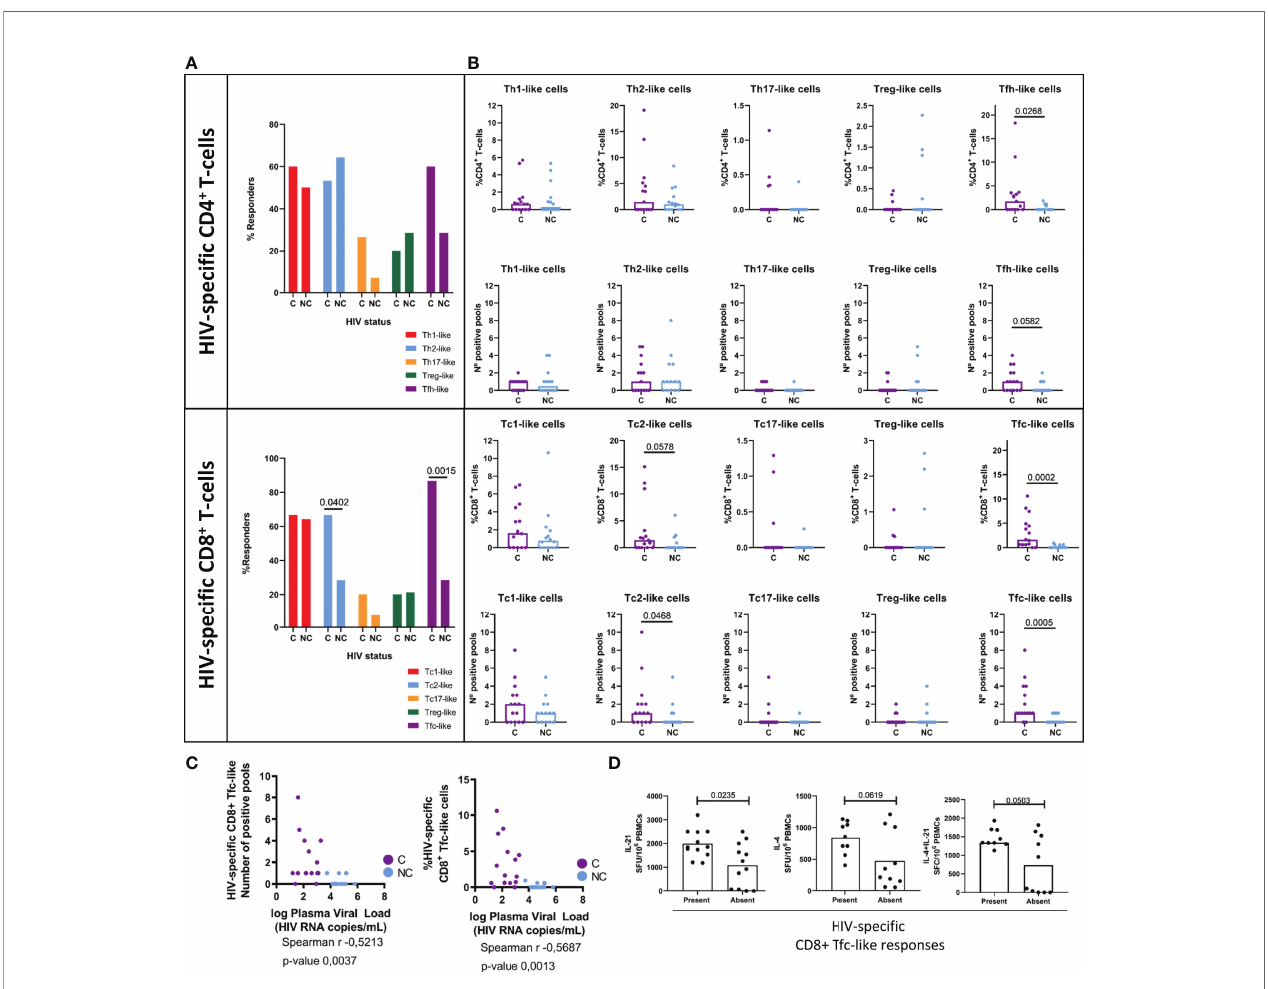
FIGURE 1 | HIV-speci fi c T-cell polarized responses. Boosted Flow screening of speci fi c-T-cell responses against whole HIV proteome in a cohort of 15 HIV+ controllers (C, purple) and 14 HIV+ non-controllers {NC, light blue) revea led a highly-diverse set of polarized T-cell responses in terms of (A) number of responders (B) percentage of circulating HIV-speci fi c T-cells (up) and number of reactive pools {down). (C) Negative correlation between plasma viral load and CDS+ Tfc-like responses to HIV measured in terms of breadth (l eft) and magnitude (right). (D) Inner capacity of total PBMCs to secrete T-follicular associated cytokines IL-21 (left scatter plot), IL-4 (middle scatter plot) and IL-21/IL-4 simultaneously (right scatter plot) upon non-speci fi c PHA stimulation strati fi ed by the presence (left bar) or the absence (right bar) of HIV-speci fi c circulating Tfc-like responses. Statistical signi fi cance of differences in frequency of responders was evaluated by Chi-square test, between group medians by non-parametric Mann-Whitney test and correlation between Tfc-like responses and plasma viral load by Spearman correlation and its correspondent p-value. Statistical signi fi cance was set on p <